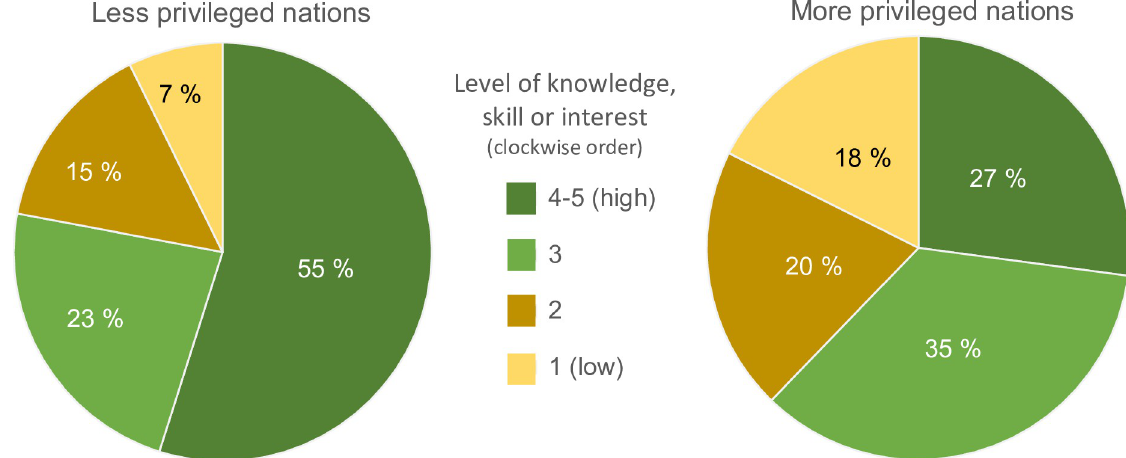
Fig 5. Teachers’ evaluation of pupils in their class, regarding levels of skills, knowledge and interests targeted in the open online course EDU-ARCTIC (2016–2019). N = 255 teachers with 25,398 pupils in the pre-survey, and 72 teachers with 3,428 pupils in the post-survey (survey types are merged in figure). Teachers were 76% females, and 99% from Europe or nations bordering Europe. We defined ‘less privileged’ as nations below median United Nations in-equality adjusted Human Development Index for Europe (IHDI = 0.815). The sample sizes for less and more privileged were 303 and 24 teachers,